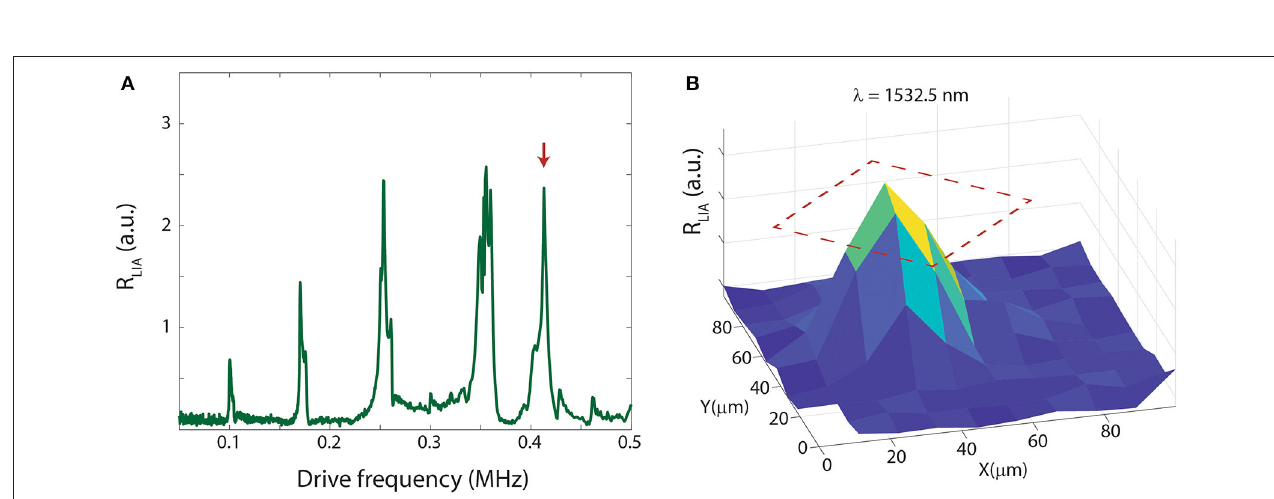
FIGURE 6 | (A) Piezo-driven mechanical spectrum at atmospheric pressure with the laser focused in the membrane center. The peaks identify the out-of-plane mechanical eigenmodes of the piezo stack. (B) Map of the LIA amplitude at 430kHz [red arrow in (A) ] around the membrane position. The full metasurface position is overlaid with a red-dashed line as a guide for the